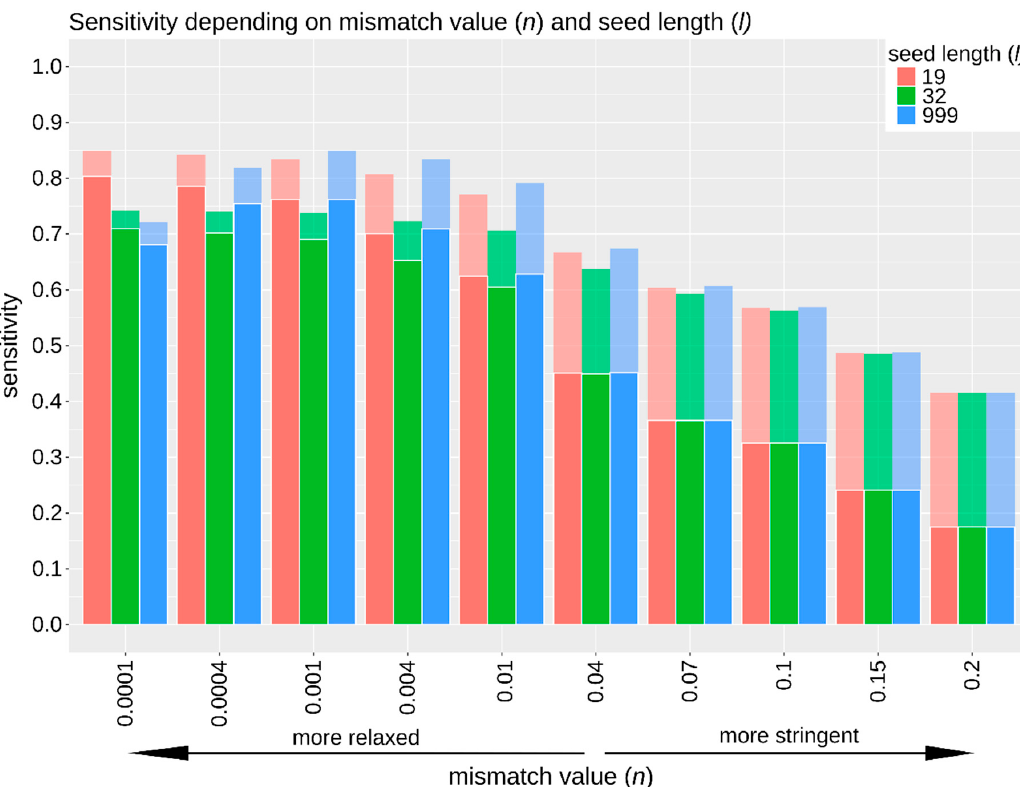
Figure 3. Sensitivity using BWA aln before (faded colors) and after (darker colors) filtering reads with low mapping quality (MapQ < 30). A total of 30 combinations of the parameters mismatch value ( n , x -axis) and seed length ( l , coloured bars, see key top right) were tested using one million simulated reads and the cat genome as reference. Increased sensitivity is achieved by relaxing the mismatch